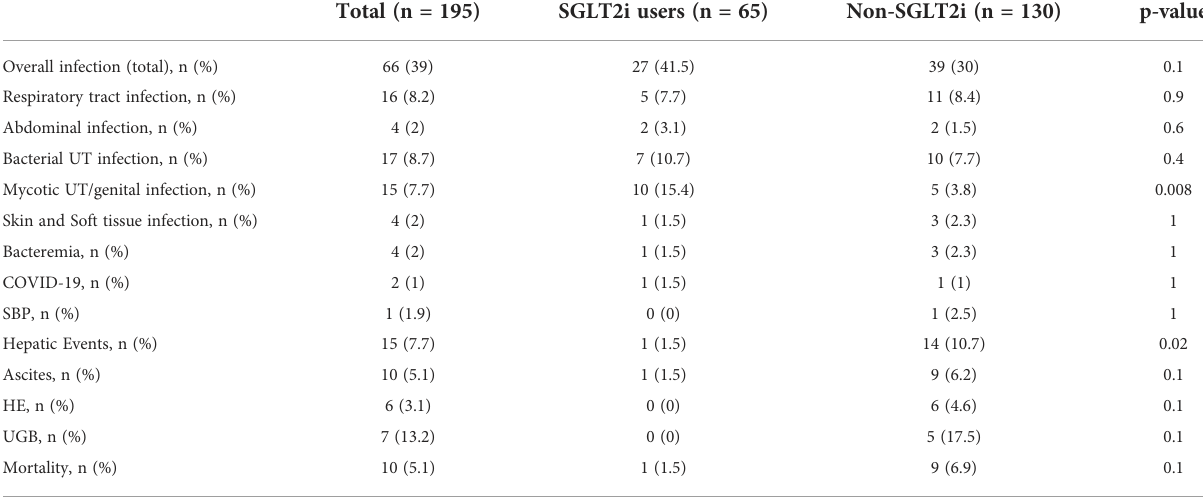
TABLE 2 Outcomes in cases (SGLT2i users) and controls (non- SGLT2i users) in a cohort of patients with NAFLD and type 2